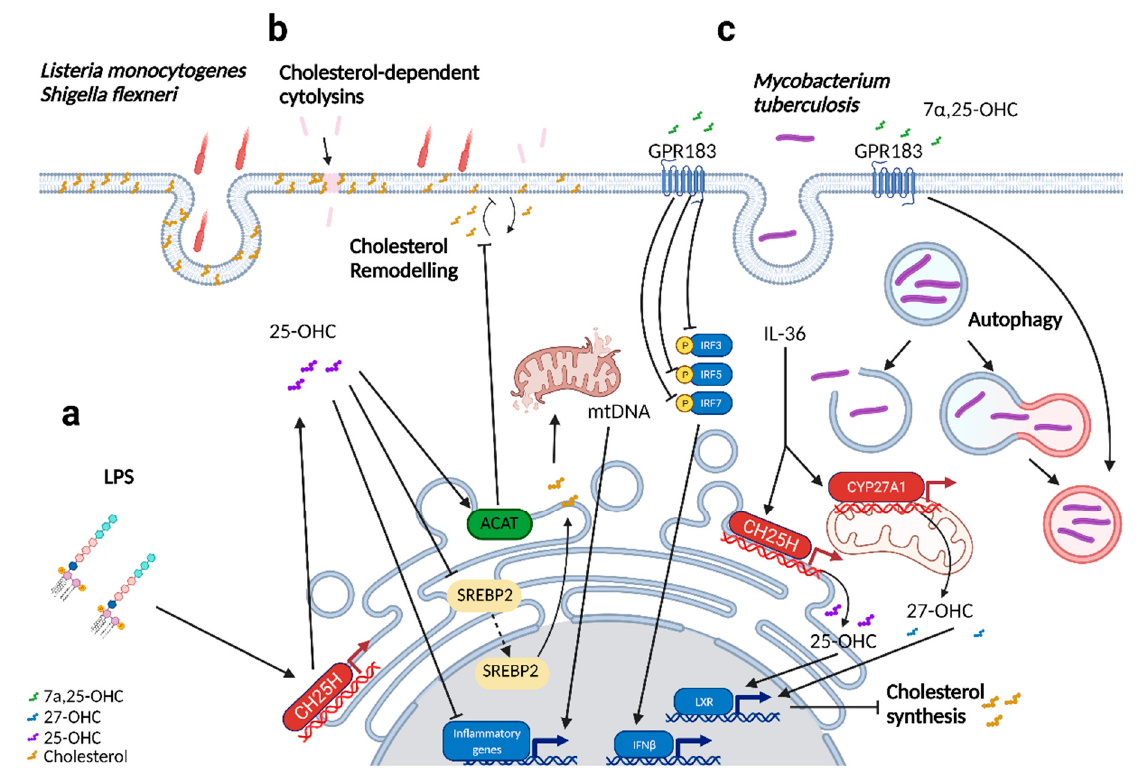
Figure 2. Mechanisms of oxysterol action in bacterial infections. Several oxysterols have host protective roles against bacterial pathogens. ( a ) In LPS models of infection, the anti-inflammatory role of the CH25H/25-OHC axis has been demonstrated in several macrophage models. In murine alveolar macrophages, 25-OHC administration led to a reduction in inflammation markers (TNF α , IL-6) though mechanisms yet to be elucidated. In BMDMs, 25-OHC represses cholesterol production by preventing SREBP2 translocation to the nucleus, preventing cholesterol-mediated mitochondrial dysfunction and the subsequent downstream inflammatory response. ( b ) 25-OHC prevents the bacterial entry of Listeria monocytogenes and Shigella flexneri through the ACAT-dependent remodeling of cholesterol on cell membranes. In addition, CH25H/25-OHC protects against CDCs-induced pore damage by similar mechanisms, preventing CDCs from binding to cell membranes. ( c ) In Mycobacterium tuberculosis (Mtb) infection, the GPR183/7 α ,25-OHC axis negatively regulates the type I IFN pathway and promotes autophagy, limiting mycobacterial growth in primary human monocytes. In addition, in human macrophages (THP-1s and monocyte-derived macrophages) Mtb- induced IL-36 facilitates the production of 25-OHC and 27-OHC, which inhibits cholesterol synthesis by activating LXR